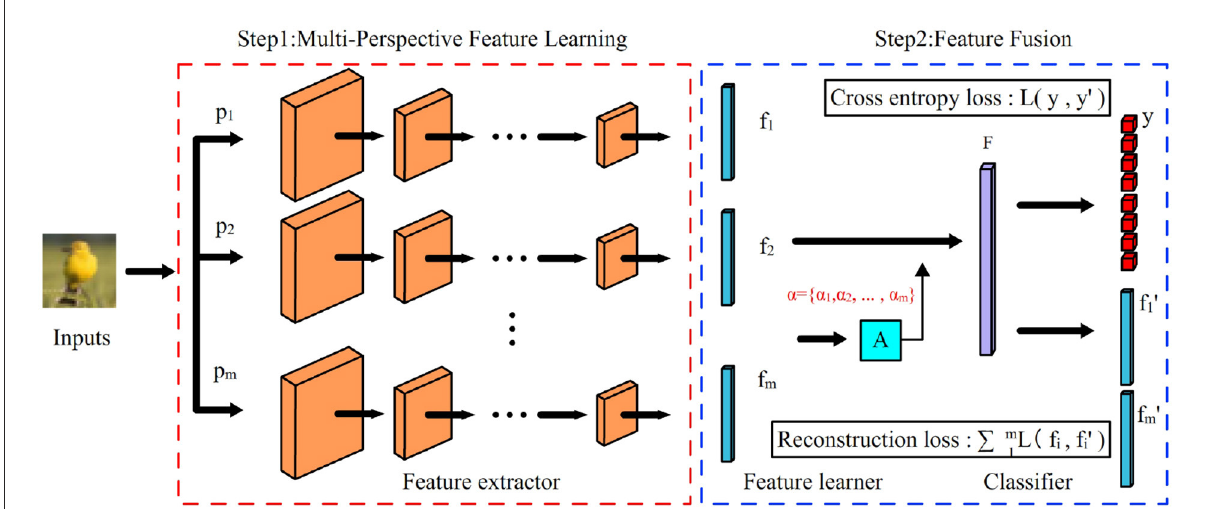
FIGURE1 Semantic enhanced OOD detection model. The model consists of three parts: a feature extractor, a feature learner, and a classifier. The feature extractor extracts the features f = { f 1 , f 2 ,..., f m } of the input samples with the given m “semantic perspectives” p = { p 1 , p 2 ,..., p m } , and the feature learner fuses the m features in f to obtain the richer and more comprehensive features F , and the classifier obtains prediction results based on the features F .